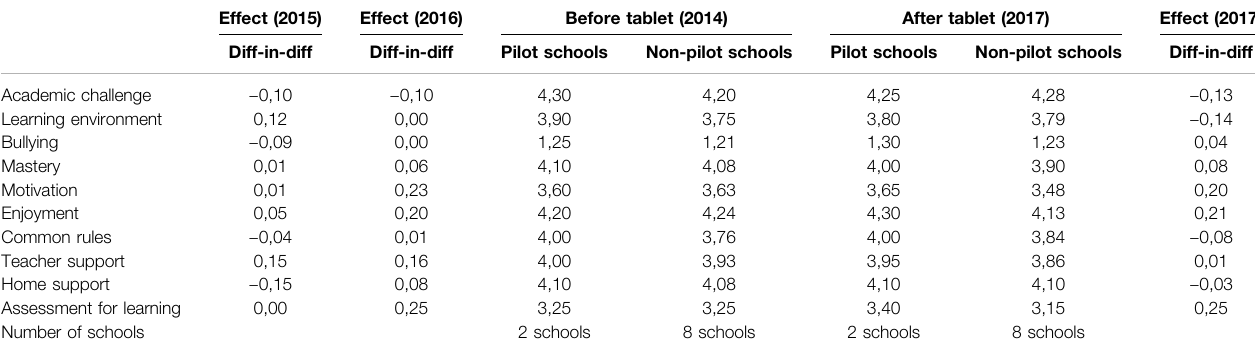
TABLE 11 | Difference-in-Difference analysis of student survey indicators, seventh grade (group